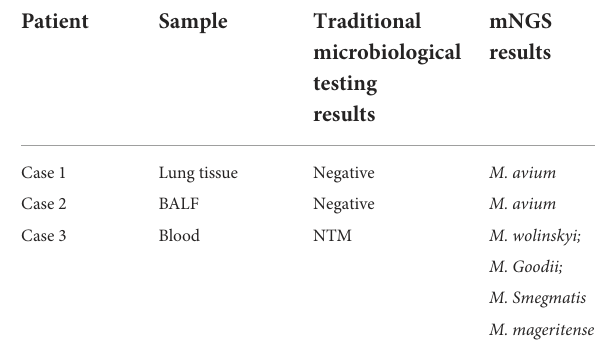
TABLE 1 Summary of results from traditional tests and